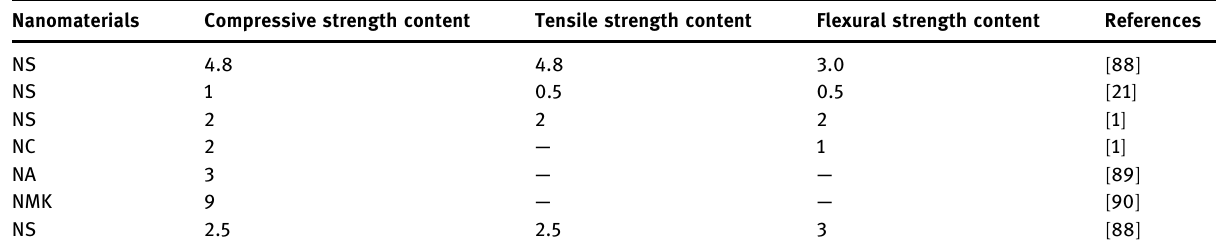
Table 3: Optimum doping amount of nanomaterials ( % )